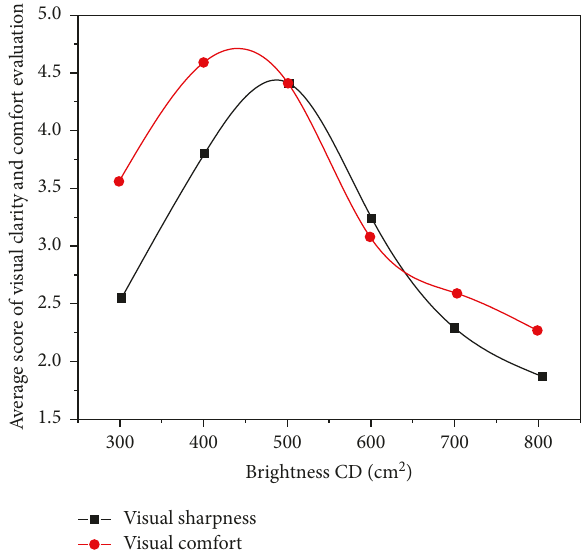
Figure 4: Relationship between brightness contrast and visual clarity and visual